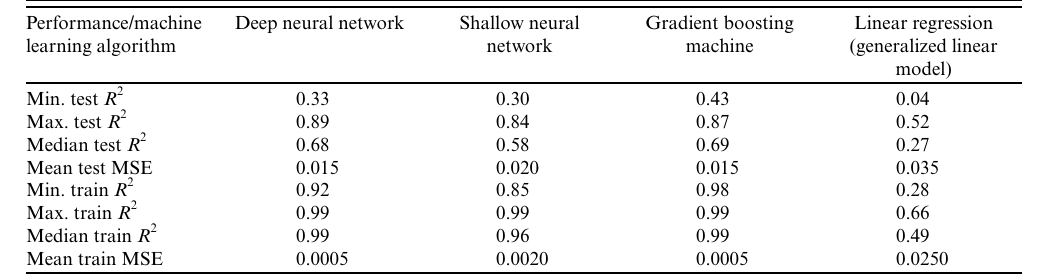
Table 1 . Performance comparison of machine learning algorithms on the common-pool resources data